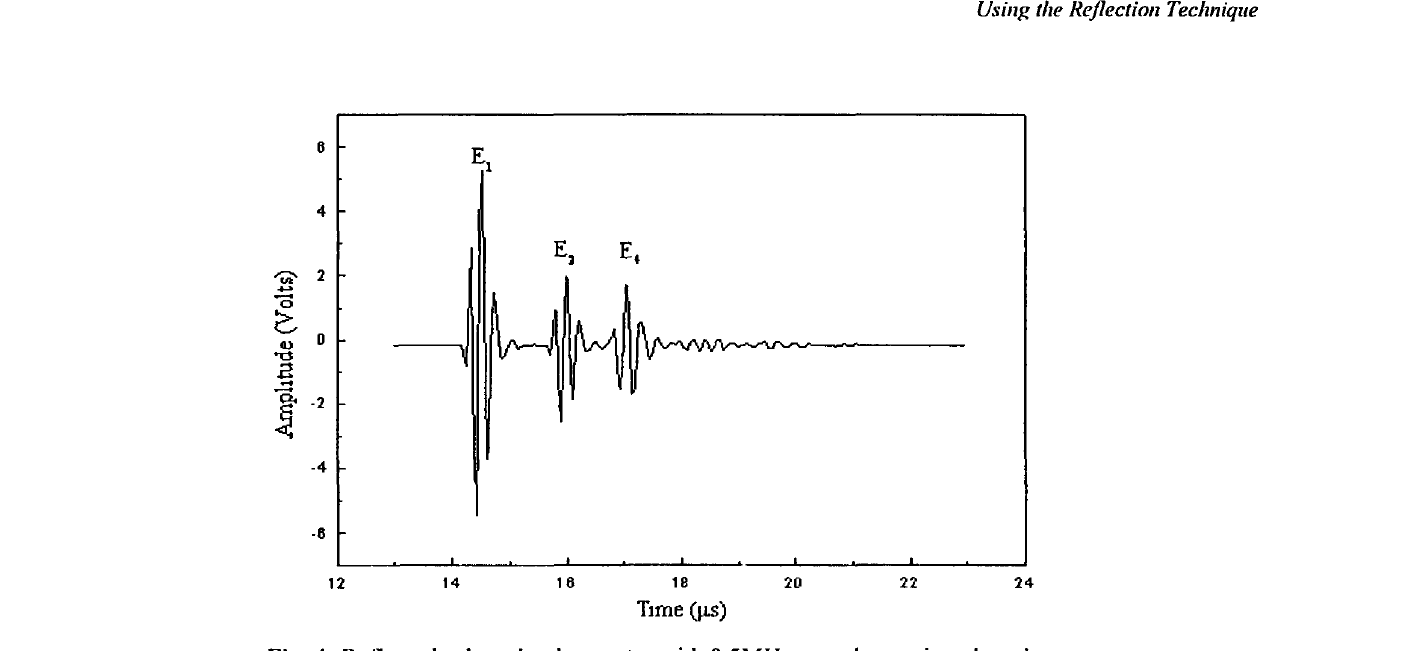
Fig. 4: Reflected echoes by the mortar with 0.5MH/ transducer, time